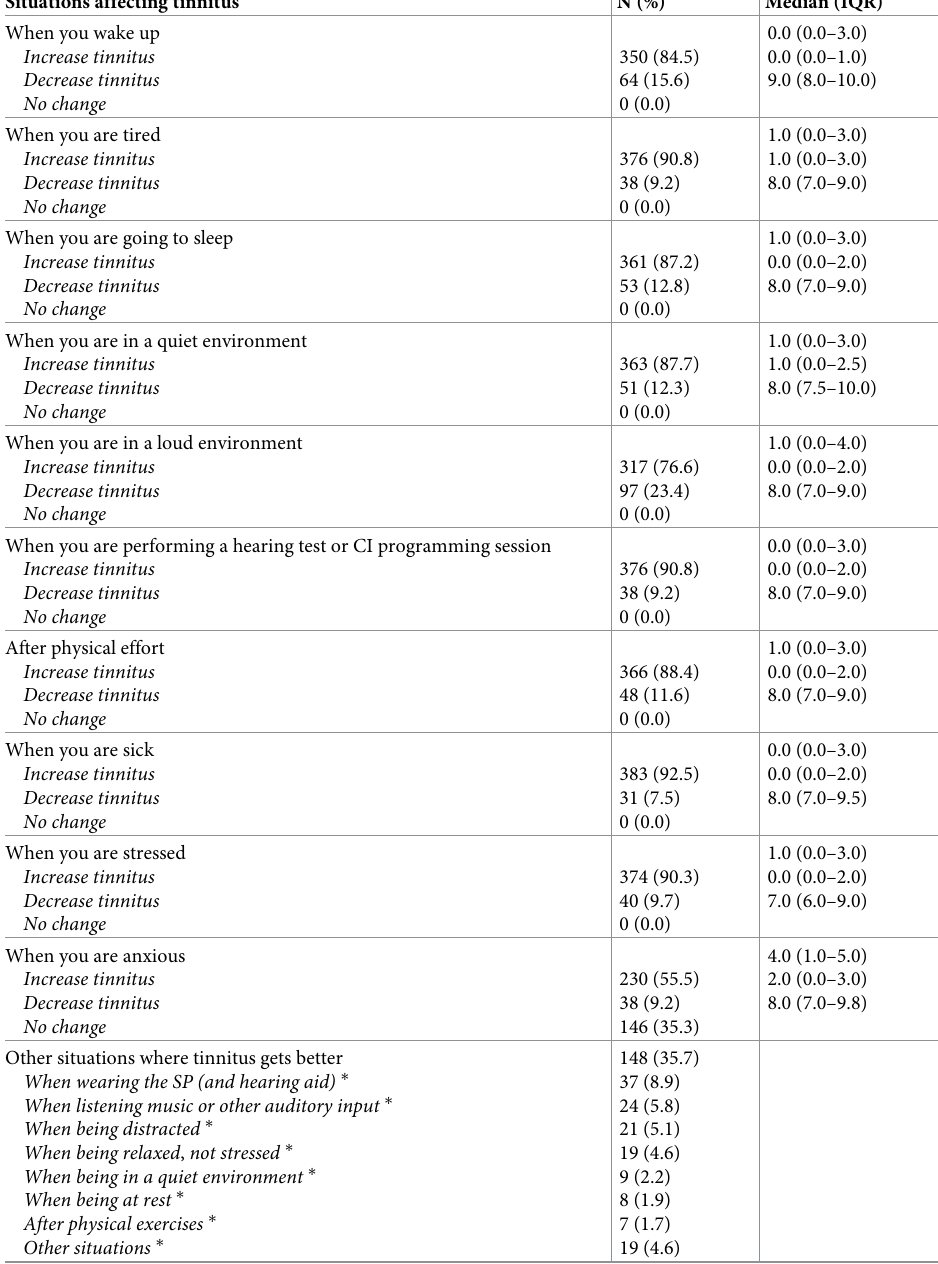
Table 4. Situations impacting